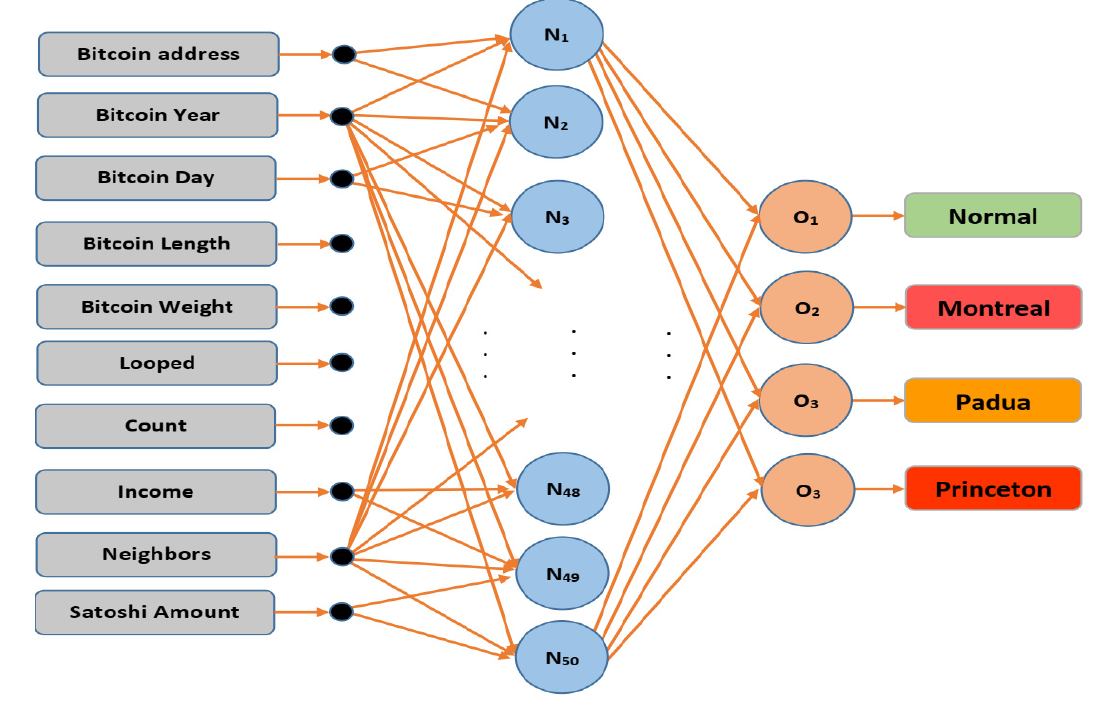
Figure 7. SNN Model Architecture for Bitcoin Transaction Predictive Model.